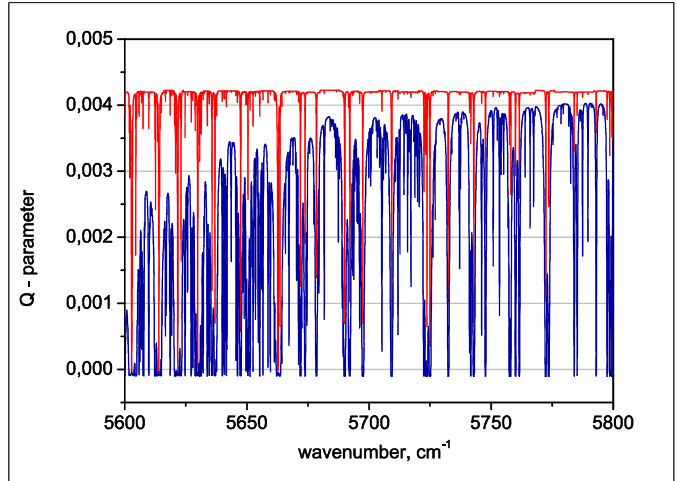
Figure 10. Differences in a spectrum of the reflected solar radiation caused by change in the aerosol structure. The same that Figure 8 (the single aerosol layer between 0–1 km, optical thickness = 0.3262, Mid-Latitude Atmospheric model) but in the spectral region of the Ω—band H O (1.87 μm). Red line – for the above homogeneous aerosol layer and blue 2 line—for a layer of the same optical thickness but with linear dependence on altitude of the volume scattering coefficient from maximal at the surface to zero at 1